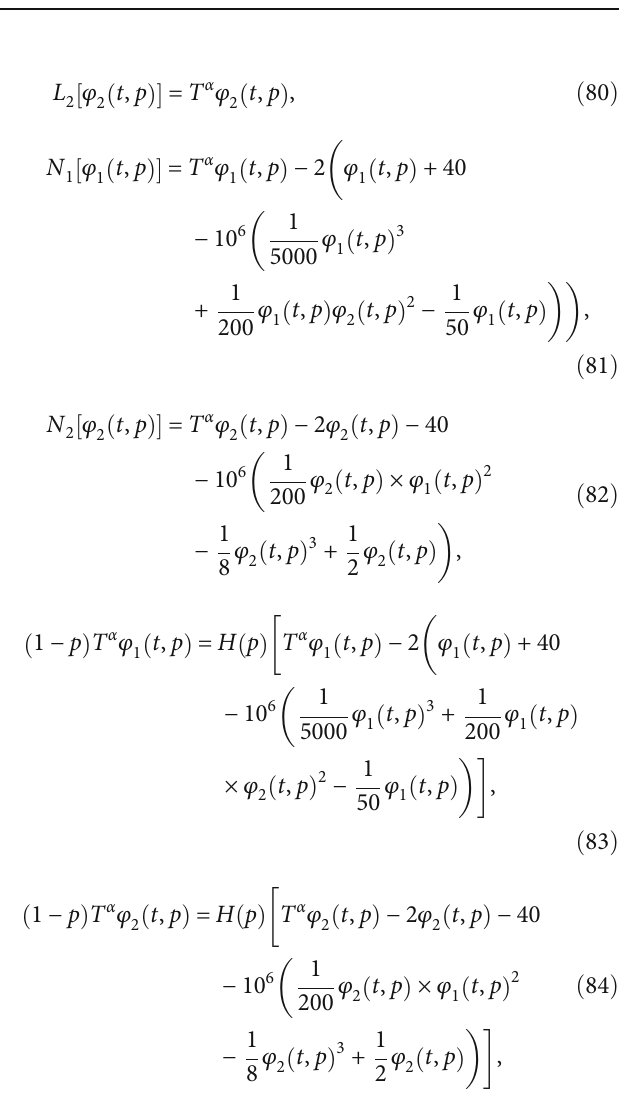
Table 1: Control-convergence parameters C